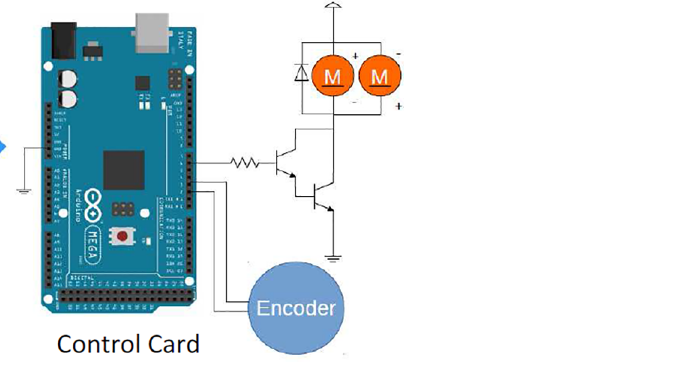
Fig 14. Electrical components of experimental